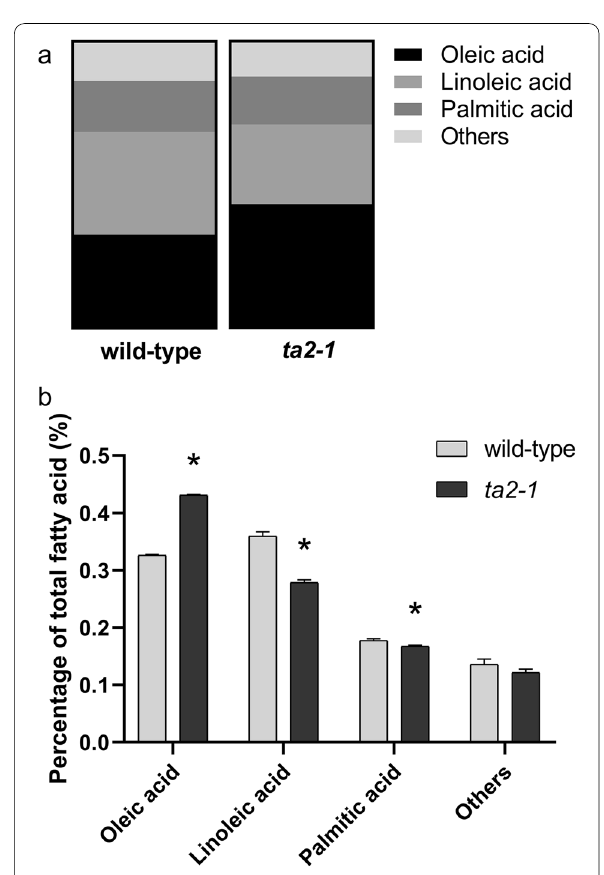
Fig. 12 Fatty acid and fatty acid composition comparison. a Fatty acid composition comparison in parts of whole format, b Fatty acid composition comparison of oleic, linoleic, and palmitic acid (* P < 0.05; ANOVA, Tukey’s HSD test; oleic, linoleic, and palmitic acid, n